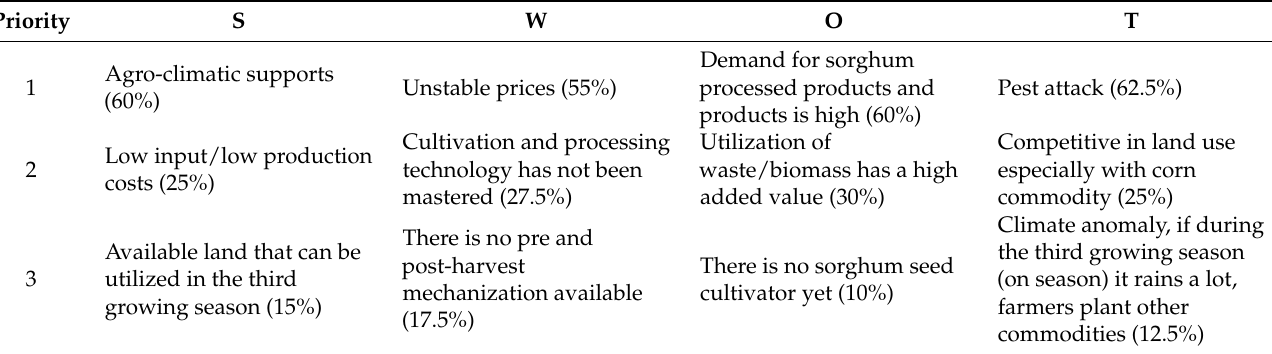
Table 3. Priority factors of SWOT to sorghum development in Wonogiri Central Java, 2022.